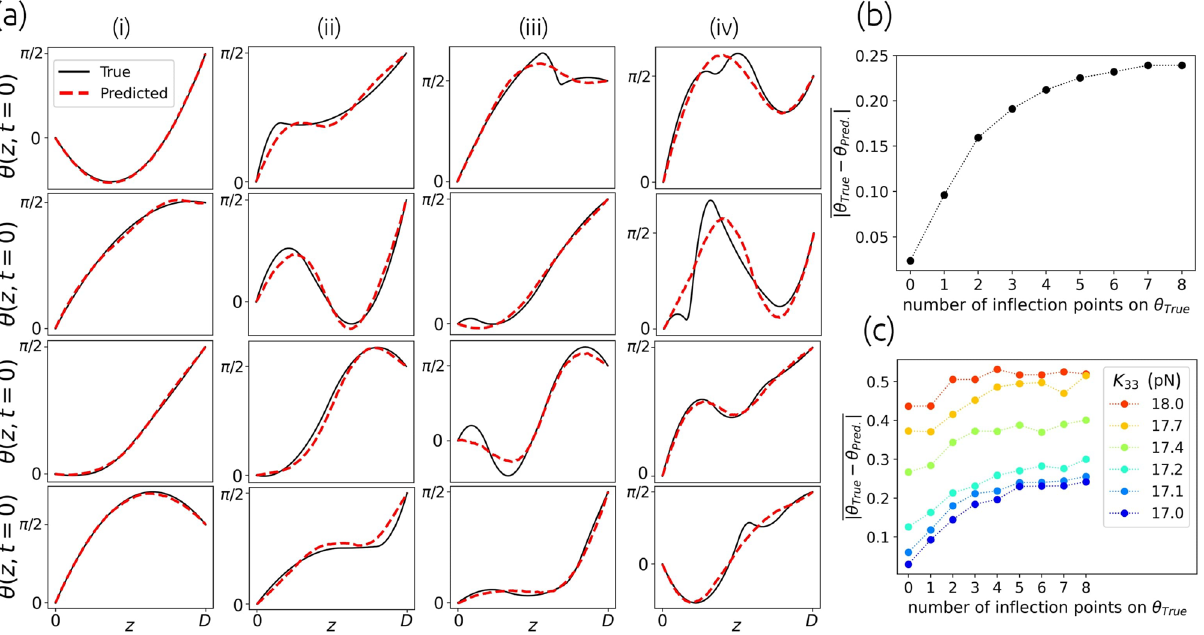
Figure 8. Determination of initial non-equilibrium state of the director n ( z , t = 0 ) = ( cos θ( z , t = 0 ) , 0, sin θ( z , t = 0 )) from the time-dependent transmittance I ( t ) for a NLC with elastic constants K 11 = 11 pN , K 33 = 17 pN . Column (i) in panel ( a ) shows examples with 0 inflection points on actual θ True ( z , t = 0 ) profiles, in column (ii) there is 1 inflection point on each θ True ( z , t = 0 ) , etc. Panel ( b ) shows the mean absolute error of predicted θ Pred. ( z , t = 0 ) that is lowest for “simple” curves without inflection points and increases with their number. The mean error is defined as inflection points, and N r = 200 is the number of discretization points. If the trained neural network is used for a nematic sample with slightly different elastic constants, the recognition of profiles θ Pred. ( z , t = 0 ) becomes less accurate, as shown in panel ( c